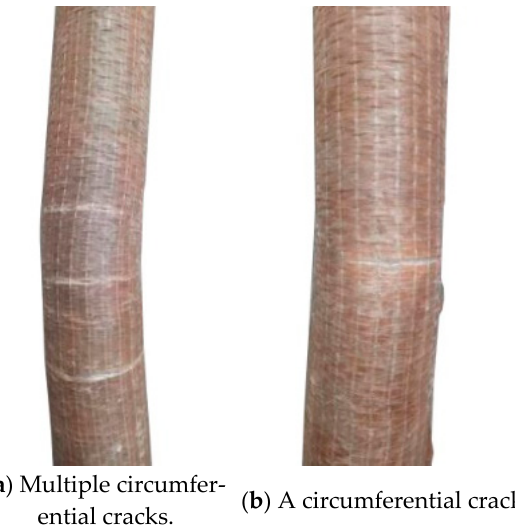
Figure 5. Local failure diagrams for FCCC-R specimens.